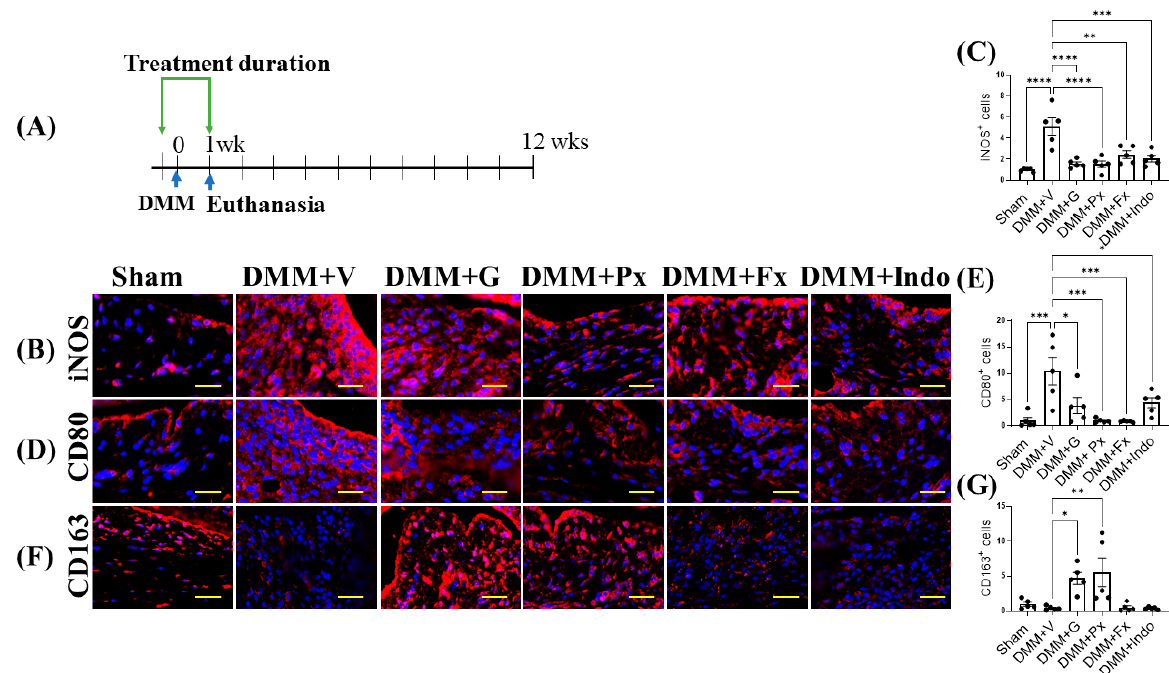
Figure 5. Early continuous G βγ -GRK2 inhibition switches synovial macrophage phenotype to M2 in early-stage PTOA. ( A ) Schematic representation of timeline of drug treatment after sham ( n = 5) or DMM surgeries. Two days before surgery, mice started receiving daily intraperitoneal injections of vehicle (V; n = 10), gallein (G; 10 mg/kg per day, n = 10), paroxetine (Px; 5 mg/kg per day, n = 7), fluoxetine (Fx; 5 mg/kg per day, n = 9), or indomethacin (Indo; 2.5 mg/kg per day, n = 9). All mice were euthanized 1 week after surgery. Green arrows denote the duration of drug treatment. Representative images of IF staining of (M1 markers) ( B ) iNOS, ( D ) CD80, and ( F ) CD163 (M2 marker) in the in the anterior femoral synovium of sham and DMM mouse knee sections 1 week after DMM or sham surgery. Target proteins are represented in red. DAPI (blue) stains nuclei; scale bar, 50 µm. Quantification of the percentage of positive cells expressing ( C ) iNOS, ( E ) CD80, and ( G ) CD163. n = 5 per group; * p < 0.05, ** p < 0.01, *** p < 0.001, and **** p < 0.0001 vs. DMM + V group using one-way ANOVA. Values are expressed as means ± SEM.